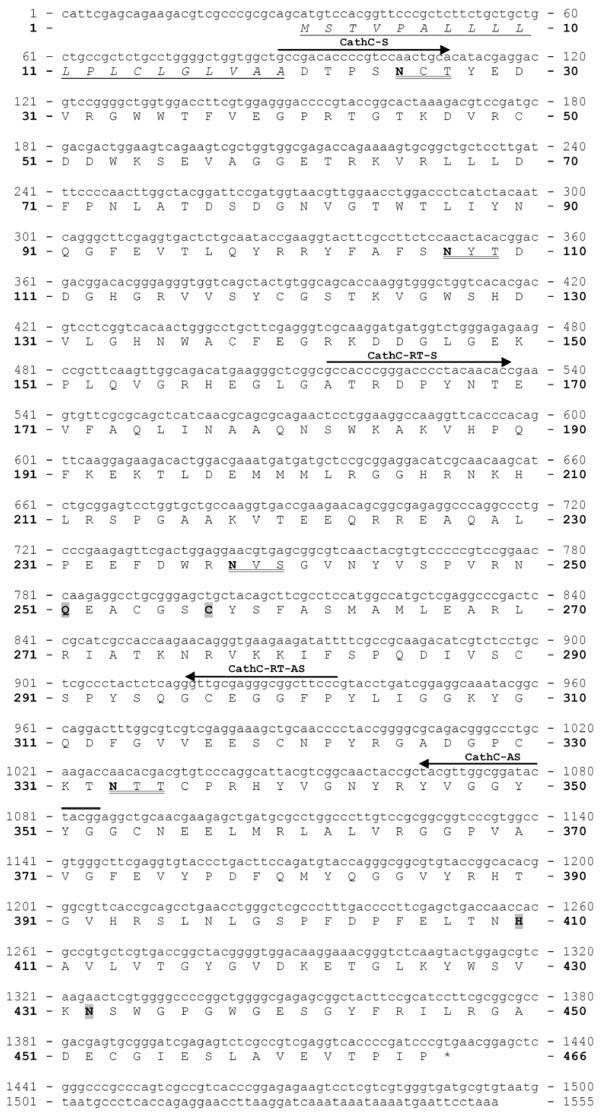
Nucleotide and deduced amino acid sequence of Ixodes ricinus cathepsin C (IrCC). The depictions of PCR primers, putative 20 AA signal peptide, four potential N-glycosylation sites and active site residues C256, H409, Q250 and N431 are as in Fig 4.